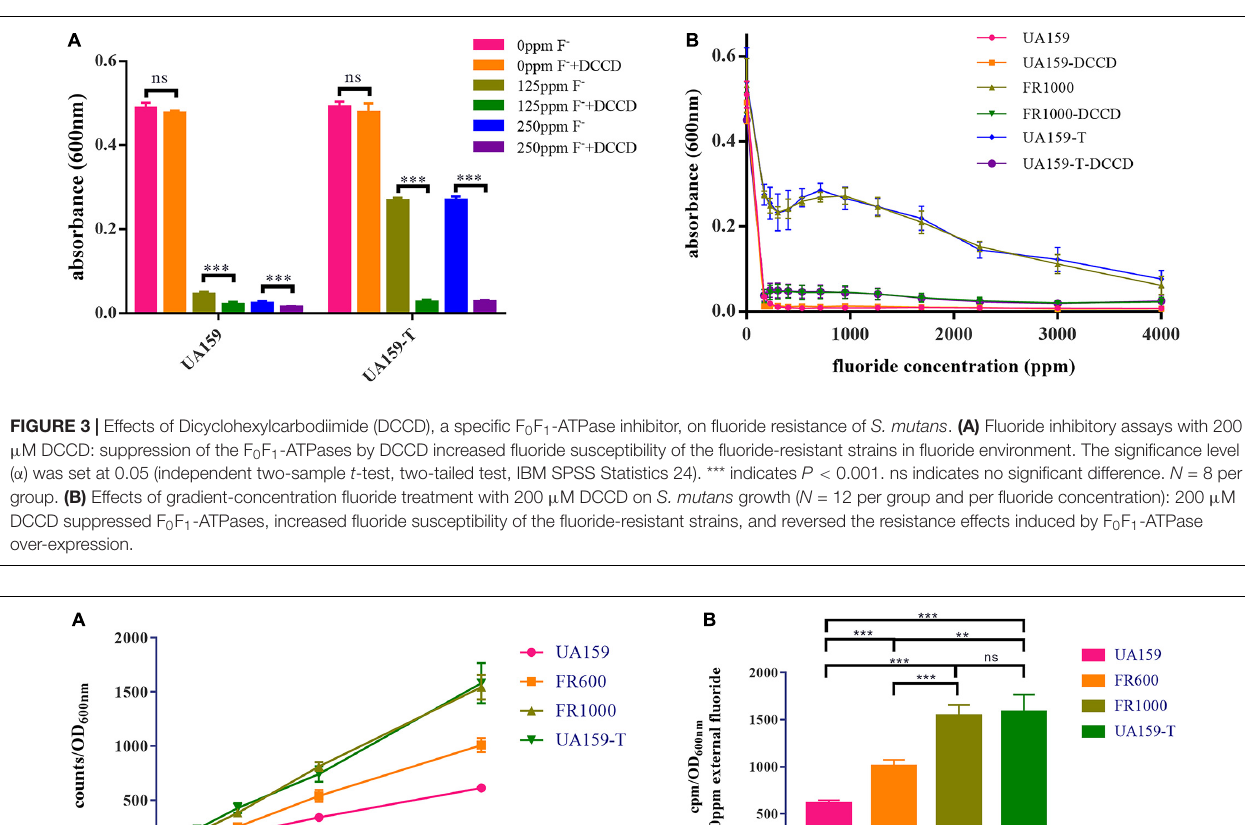
P = 0.012 in mandibula/Ds; P = 0.002 in total/Ds).